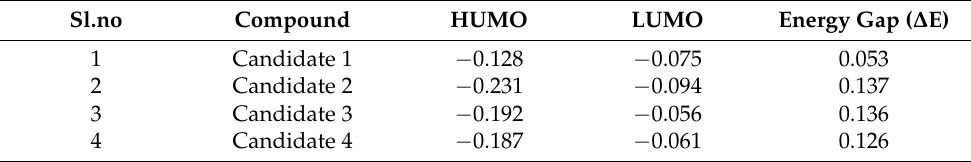
Table 5. HOMO and LUMO values calculated for identified